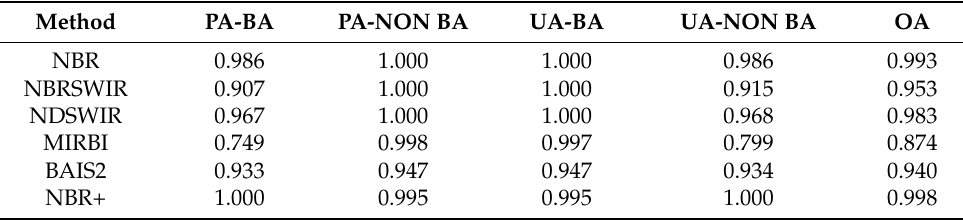
Table 5. Results of bi-temporal thematic accuracy assessment on test sites excluding water bodies and clouds (Group